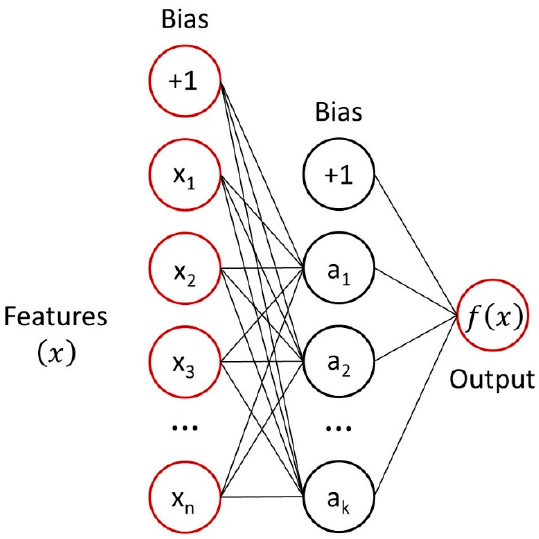
Figure 2. Basic multilayer perceptron architecture.